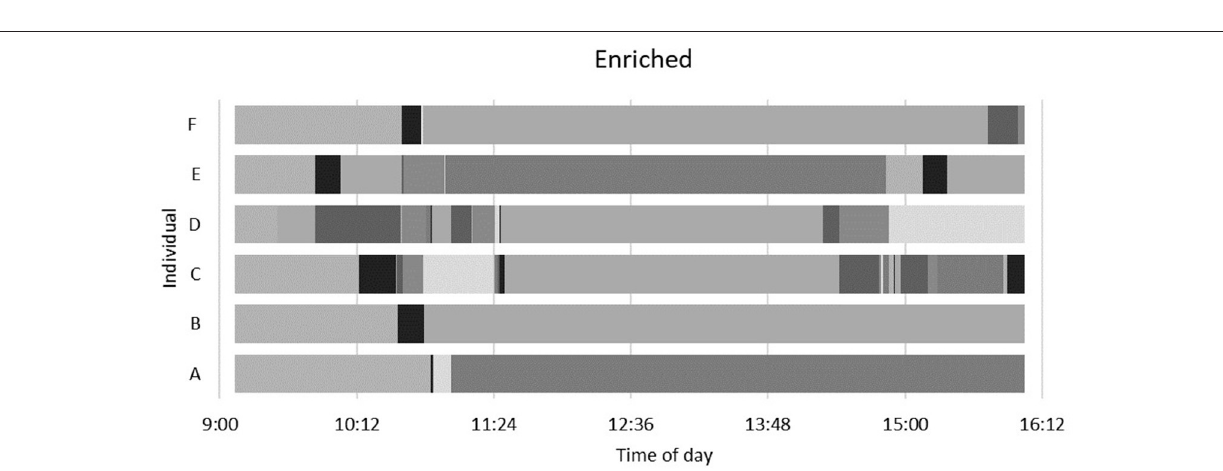
FIGURE 7 | Tracks per individual in the enriched environment including false positive tracks corresponding to the time of